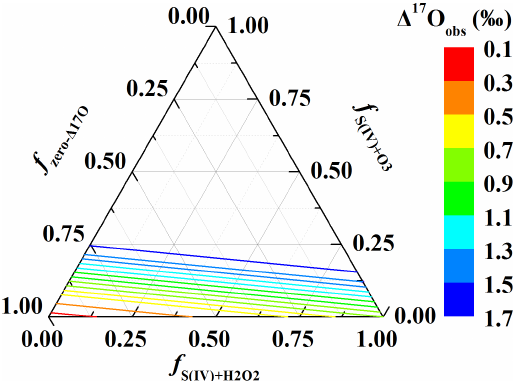
Figure 2. Ternary diagram of possible fractional contribution of different pathways to total sulfate production directly esti- mated from (cid:49) 17 O obs . The colored lines are contour lines of (cid:49) 17 O obs , representing possible fractional contribution of sul- ) fate formation via O 3 ( f S ( IV ) + O ) and H 2 O 2 ( f S ( IV ) + H 2 O 2 3 oxidation or zero- (cid:49) 17 O processes ( f ) such as pri- zero − (cid:49) 17 O mary sulfate, secondary sulfate formed via OH oxidation, NO 2 oxidation, and O 2 oxidation. f S ( IV ) + H is in the range 2 O 2 n o (cid:49) 17 O obs / 0 . 7‰ ,( 6 . 5‰ − (cid:49) 17 O obs )/ 5 . 8‰ of 0 to min , = ((cid:49) 17 O − 0 . 7‰ × f f S ( IV ) + O obs S ( IV ) + H 2 O 2 )/ 6 . 5‰, and 3 = ( 6 . 5‰ − (cid:49) 17 O − 5 . 8‰ × f f obs S ( IV ) + H 2 O 2 )/ 6 . 5‰. zero − (cid:49) 17 O See Eq. (6) and its caption in Sect. 2.7 for